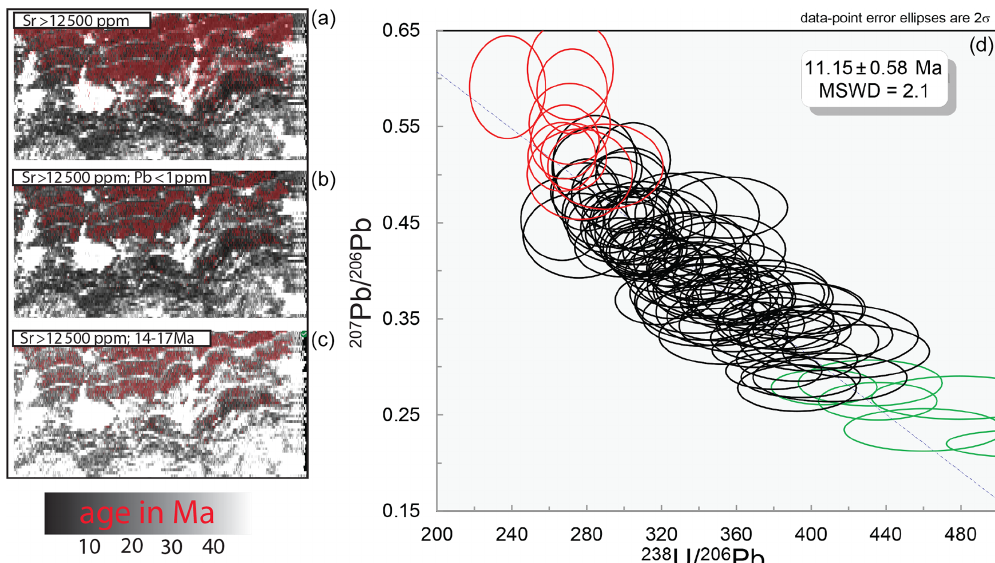
Figure 16. The base map for all 238 U − 206 Pb ages. This is the same map from Fig. 15 and is about 5mm wide. In the top map, the red pixels are greater than 12500ppm Sr. Red pixels in the middle map are also greater than 12500ppm Sr, and the Pb concentration is less than 1ppm. Red pixels in the lower map are greater than 12500ppm Sr and have an age range from 14 to 17Ma with no correction for common Pb. The isochron plot is a binning of all of the red pixels from the second map (Sr concentrations greater than 12500ppm and Pb concentrations less than 1ppm). Red and green data points represent the low and high tails, respectively.